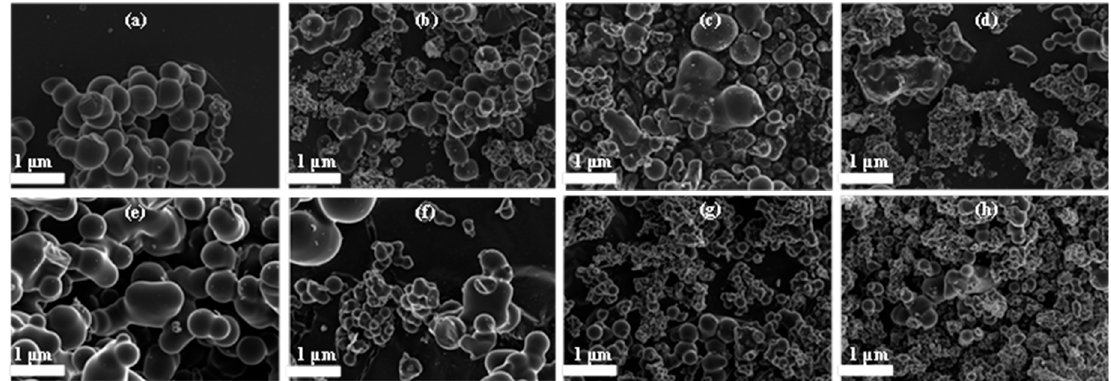
Figure 1. SEM low magnification images of ( a ) neat C, ( b ) neat 1%TiO 2 C, ( c ) neat 5%TiO 2 C, ( d ) neat 10%TiO 2 C, ( e ) C_S solid acid catalyst, ( f ) 1%TiO 2 C_S solid acid catalyst, ( g ) 5%TiO 2 C_S solid acid catalyst, and ( h ) 10%TiO 2 C_S solid acid catalyst.